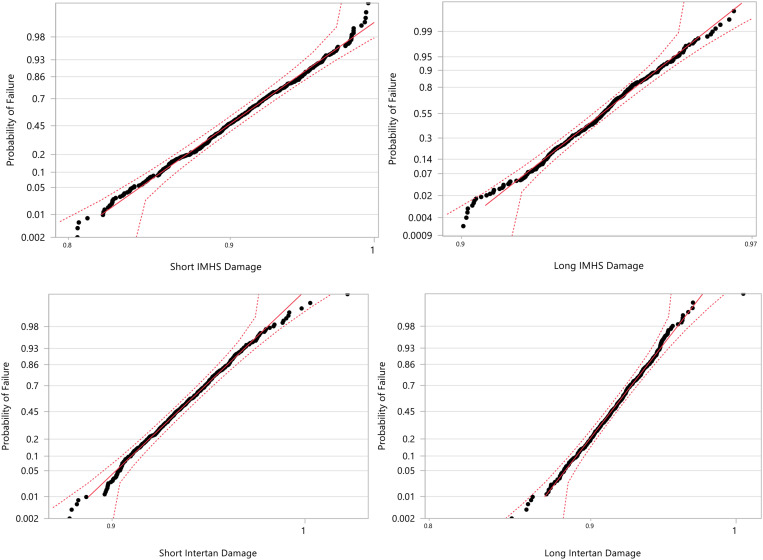
A lognormal distribution curves for each CM nail damage through Monte Carlo simulations for 500 variables.